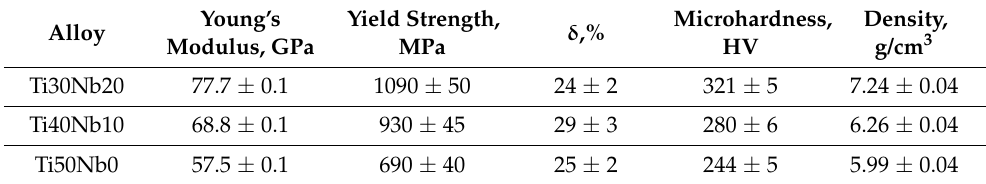
Figure 2. Engineering stress-strain curves of the program alloys obtained during tension at 20 °C with a nominal strain rate of 10 − 3 s − 1 ( a ) and corresponding strain-hardening rate behavior as a function of true strain ( b ). Table 1. Mechanical properties and density of all the program alloys.